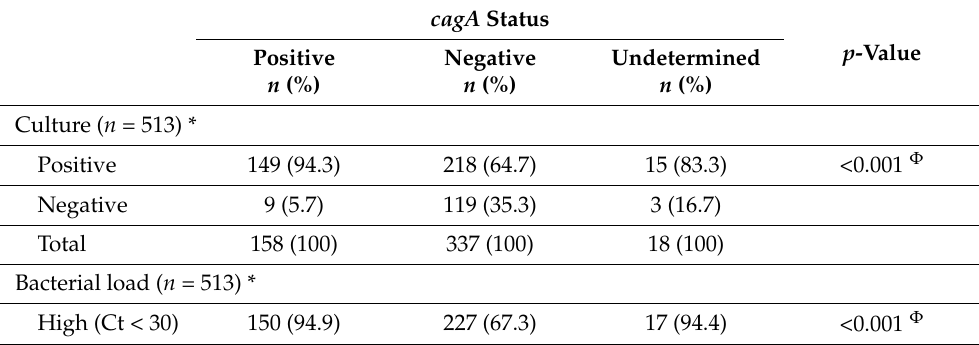
Table 4. Association between culture positivity, bacterial load (qPCR Ct values), presence of H. pylori on histology and cagA status of the